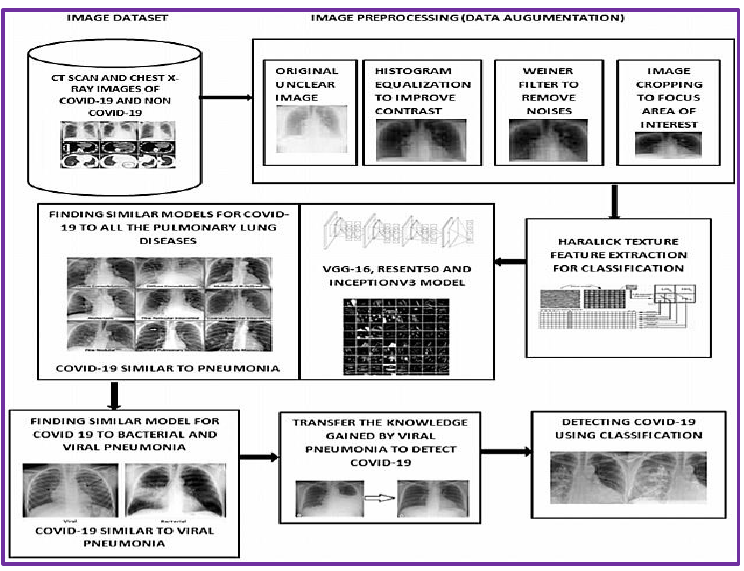
Figure 2. Transfer learning from pneumonia classification models to detect COVID-19 disease [7].